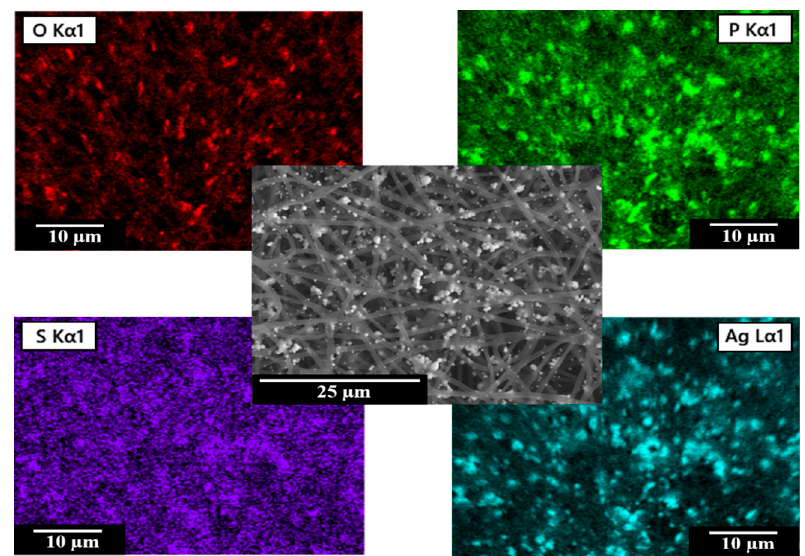
Figure 3. Elemental mapping of SAP/PAN.